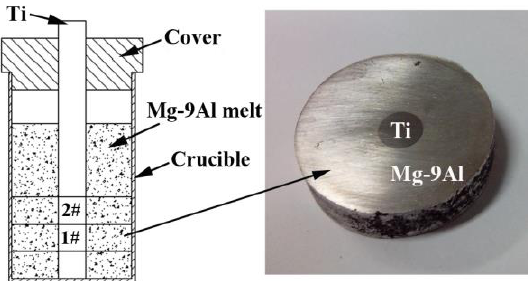
Figure 1. The schematic sketch of preparing Mg-9Al/Ti metallurgical bonding prepared by liquid-solid diffusion couples.